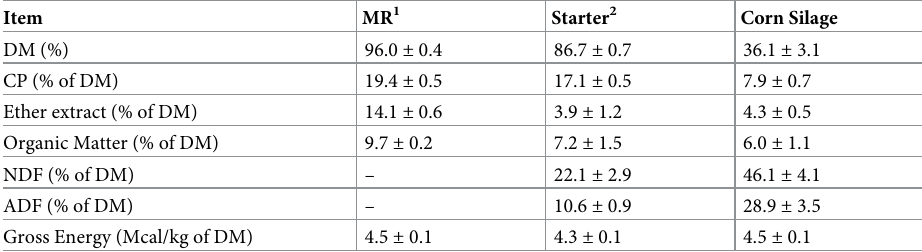
Table 1. Nutrient composition (% DM basis ± SD) of Milk Replacer (MR), starter, and corn silage.